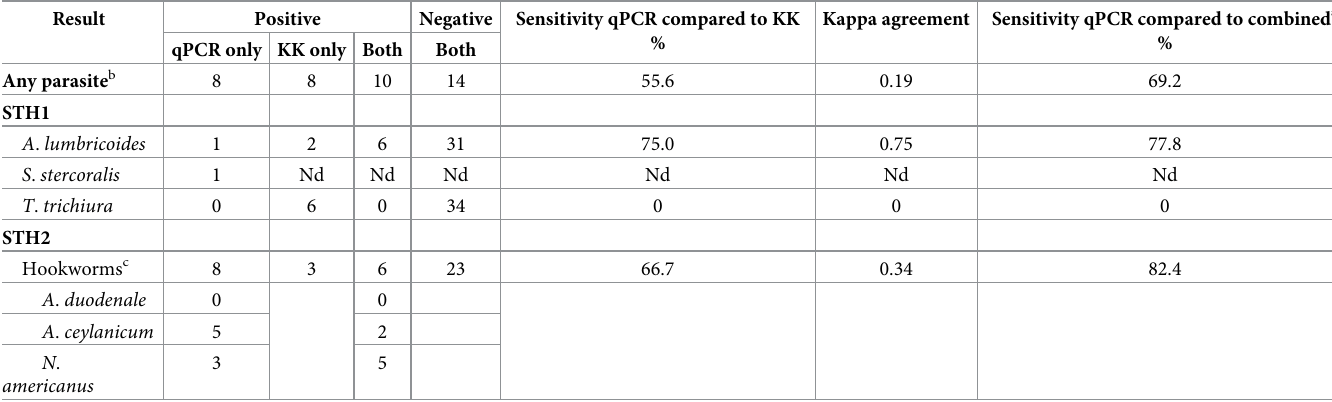
Table 3. Validation of the STH1 and STH2 qPCRs.